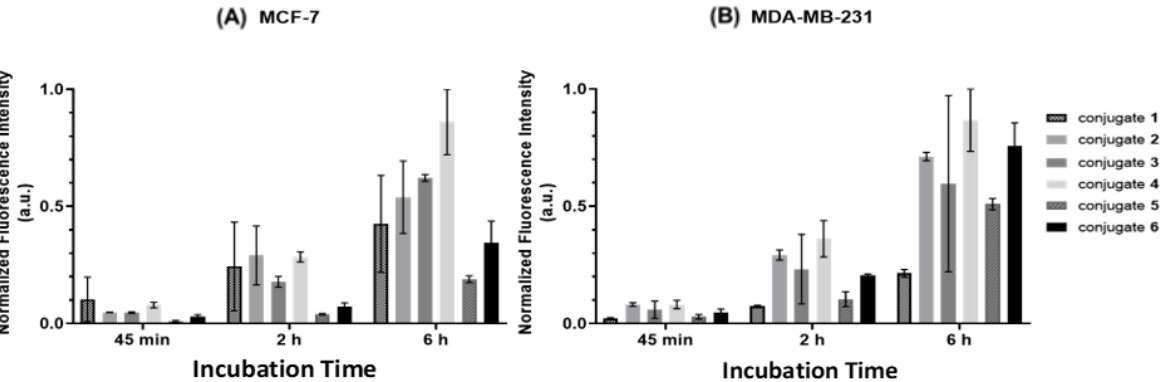
Figure 1. Normalized fluorescence intensities of MCF-7 ( A ) and MDA-MB-231 cells ( B ) upon incubation with steroid-BODIPY conjugates 1 – 6 .